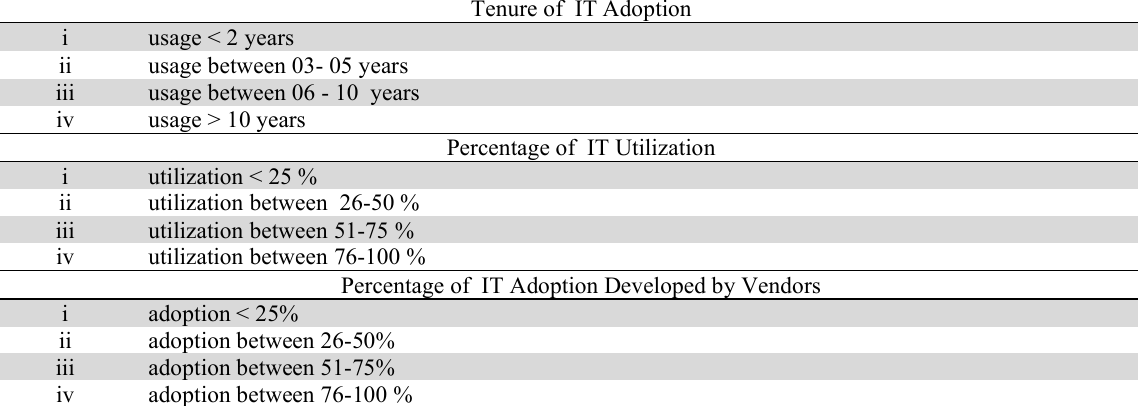
Variables used for IT usage